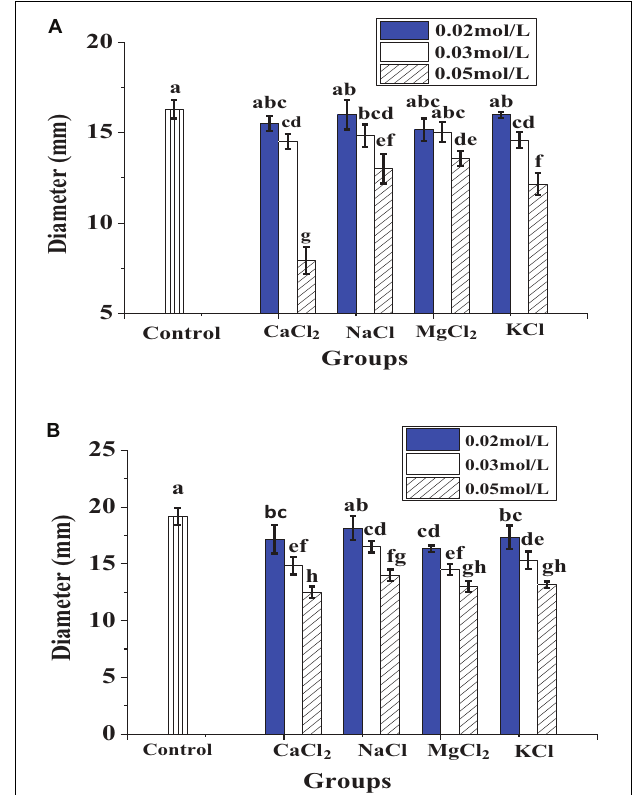
FIGURE 2 | The effects of enzymes on antibacterial activity. The bactericidal effect against E. coli and S. aureus (A) , in which different lowercase letters meant that the bactericidal effect was significantly different ( P < 0.05). The photographs of enzyme treatment on antibacterial activity against E. coli (B) and against S. aureus (C) .